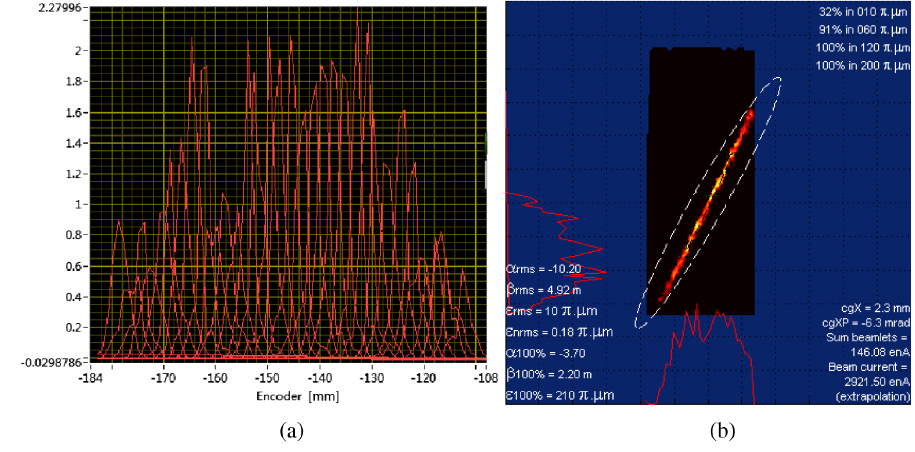
FIG. 27. The measured beam cross section and horizontal emittance at the exit of